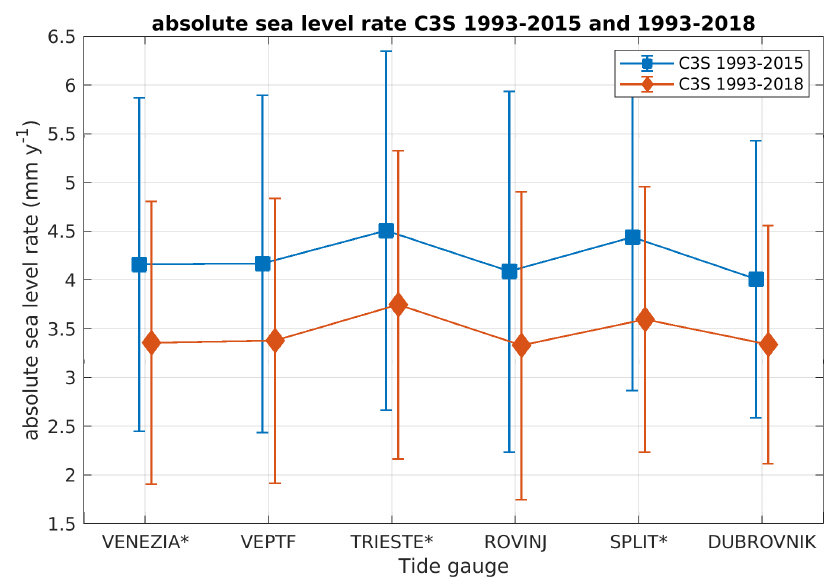
Figure 10. Pooled means and standard deviations of absolute sea level change rates associated with six TG locations and obtained from C3S during 1993–2018 and 1993–2018. Anomalous value of absolute sea level change rate found for SLCCI 1993–2015 does not shows up for C3S 1993–2015, strengthening the suspicion of some local inconsistency of SLCCI dataset near Trieste.